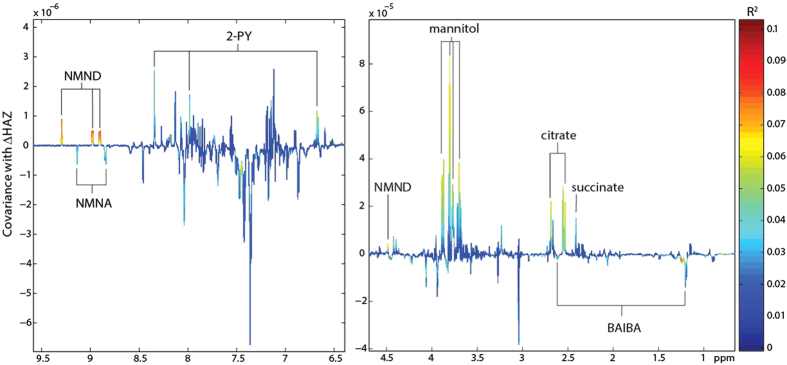
OPLS coefficients plot identifying metabolic predictors of growth in stunted children or those at risk of stunting.Baseline urinary metabolic profiles of children with a baseline HAZ <−1 correlated with ΔHAZ measured two to five months later. 2-PY, N-methyl-2-pyridone-5-carboxamide; BAIBA, β-aminoisobutyric acid; NMNA, N-methylnicotinic acid; NMND, N-methylnicotinamide.